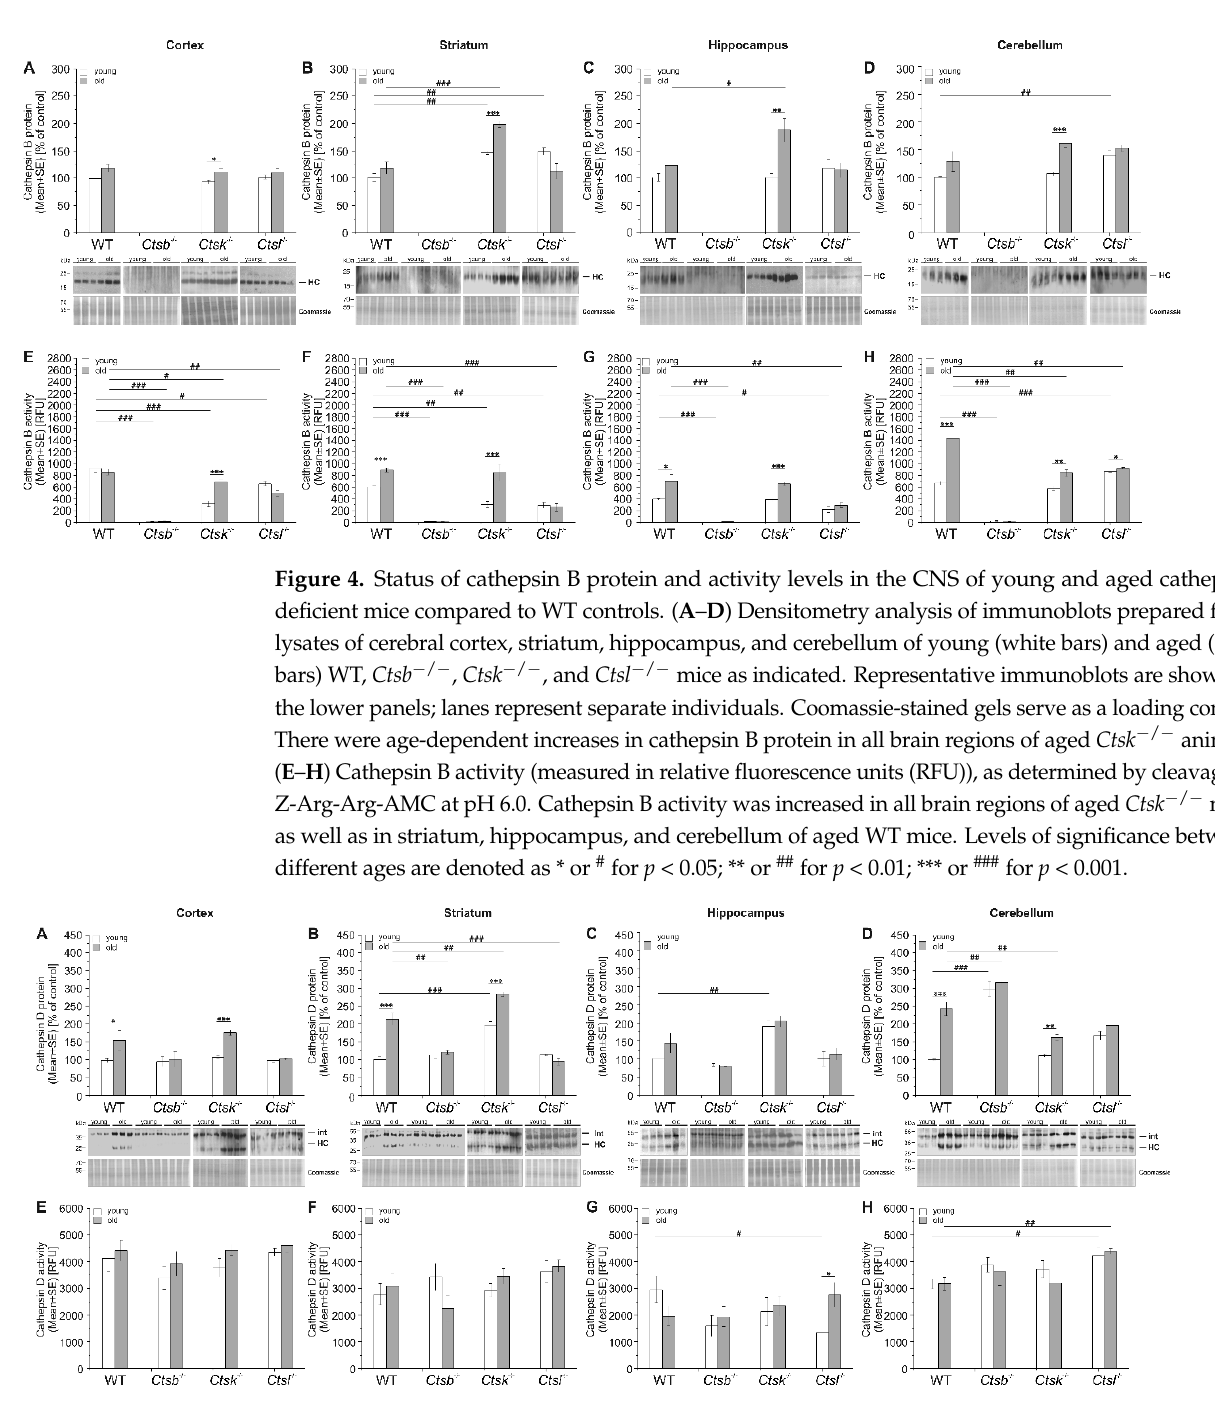
Figure 5. Status of cathepsin D protein and activity levels in the CNS of young and aged cathepsin-deficient mice compared to WT controls. ( A – D ) Densitometry analysis of immunoblots prepared from lysates of cerebral cortex, striatum, hippocampus, and cerebellum of young (white bars) and aged (gray bars) WT, Ctsb −/− , Ctsk −/− , and Ctsl −/− mice as indicated. Representative immunoblots are shown in the lower panels; lanes represent separate individuals. Coomassie-stained gels serve as a loading control. There were age-dependent increases in cathepsin D protein in cortex, striatum, and cerebellum of aged Ctsk −/− and WT animals. ( E – H ) Cathepsin D activity (measured in relative fluorescence units (RFU)), as determined by cleavage of MOCAc-Gly-Lys-Pro-Ile-Leu-Phe~Phe- Arg-Leu-Lys (Dnp)-D-Arg-NH2 at pH 4.0. Cathepsin D activity was increased in the hippocampus of aged Ctsl −/− mice. Levels of significance between different ages are denoted as * or # for p < 0.05; ** or ## for p < 0.01; *** or ### for p < 0.001.